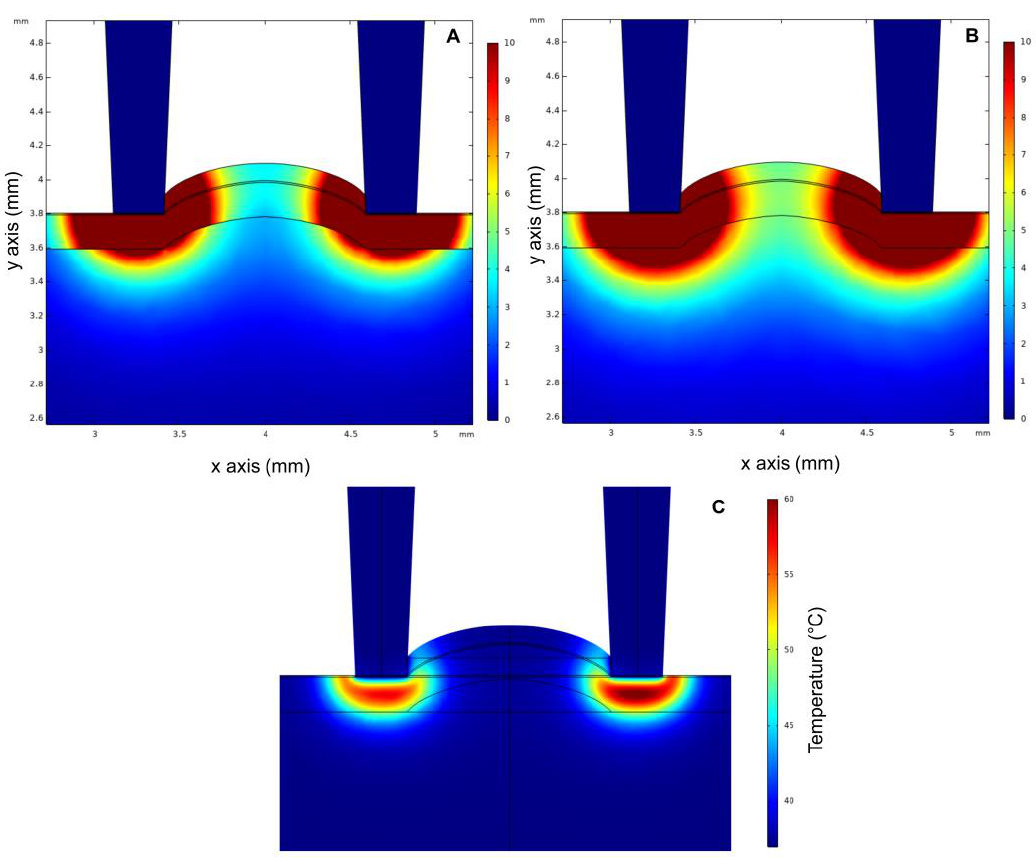
Figure 4. The spatial distribution of the electric field during pulsed electric field treatment, where ( A ) tissue conductivities are nominal and not affected by PEF; ( B ) tissue electrical conductivities are increased due to permeabilization triggered by PEF; ( C ) Joule heating due to PEF application. A 3 kV voltage is applied between the terminals (gap 1.2 mm). The electric field spatial distribution data are shown in kV/cm.